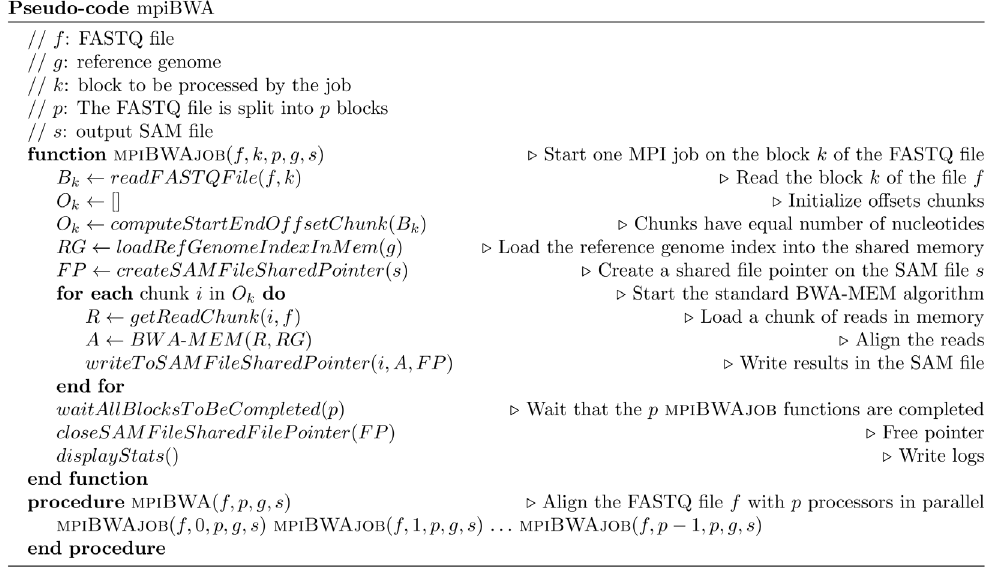
Figure 2. Pseudo-code of the mpiBWA which launches the function mpiBWAjob in parallel over p